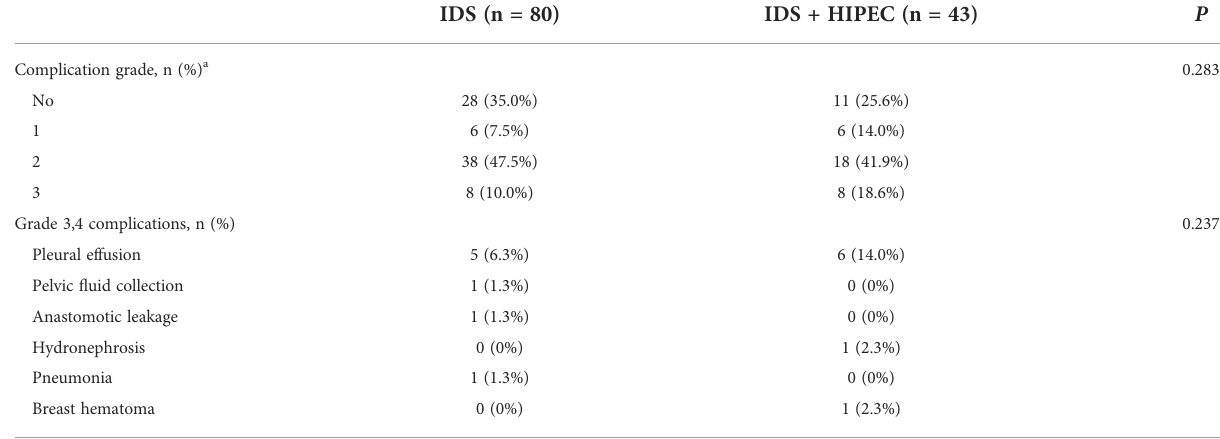
TABLE 3 Postoperative complications according to the Memorial Sloan-Kettering Cancer Center surgical secondary events grading system from days 0 to